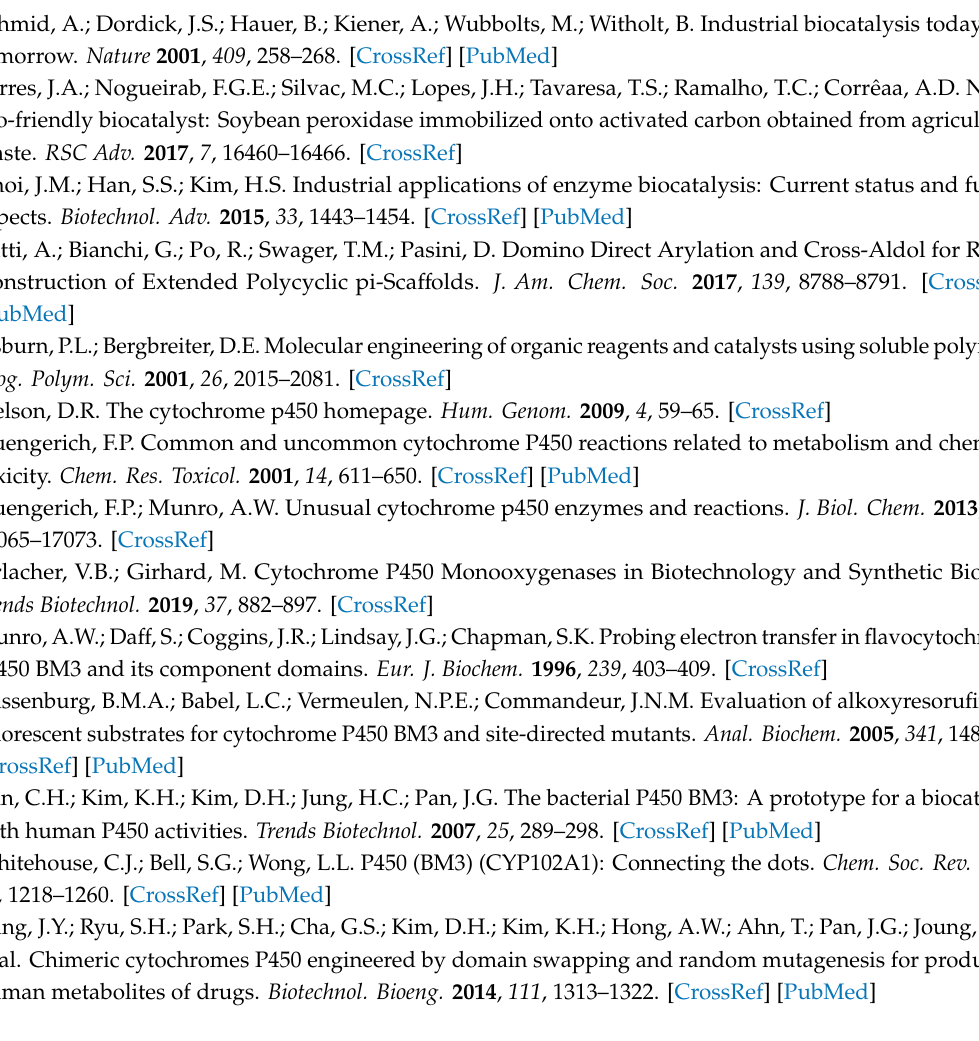
Figure S1: Total turnover numbers of engineered CYP102A1 enzymes. Figure S2: Total ion chromatography and mass scan of RD and product of M16. Figure S3: 1 H NMR spectra of RD (a) and the major product of M16 (b), Figure S4: Comparison of aromatic region in the 1 H NMR spectra of RD (a) and the major product of M16 (b), Figure S5: 13 C NMR spectra of RD (a) and the major product of M16 (b), Figure S6: Comparison of quaternary peaks in the 13 C NMR spectra of RD (a) and the major product of M16 (b), Figure S7: Chemical structures of RD and RD-catechol, Figure S8: RD-quinone formation by Ty was analyzed by UV–Vis spectrophotometer, Figure S9: Inhibition of RD-quinone formation by L-ascorbic acid (LAA), D-ascorbic acid (DAA), and dehydroascorbic acid (DHA) at 25 ◦ C, Figure S10: E ff ects of temperature on conversion rate of CYP102A1 and Ty, Figure S11: HPLC chromatogram of RD and RD-catechol produced by Ty, Figure S12: Total ion chromatography and mass scan of RD and product of Ty, Figure S13: 1 H NMR spectra of products of M16 (a) and Ty (b), Figure S14: 13 C NMR spectra of products of M16 (a) and Ty (b), Table S1: 1 H and 13 C chemical shifts of RD and RD-catechol, Table S2: Changed amino acid residues of the engineered CYP102A1 used in this